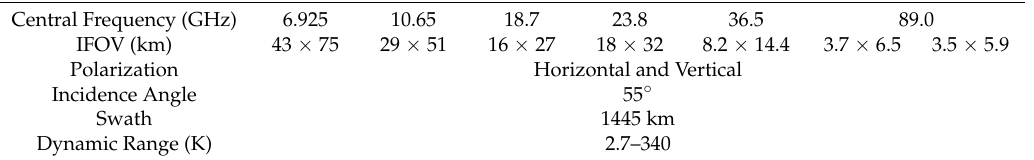
Table 1. The characteristics of